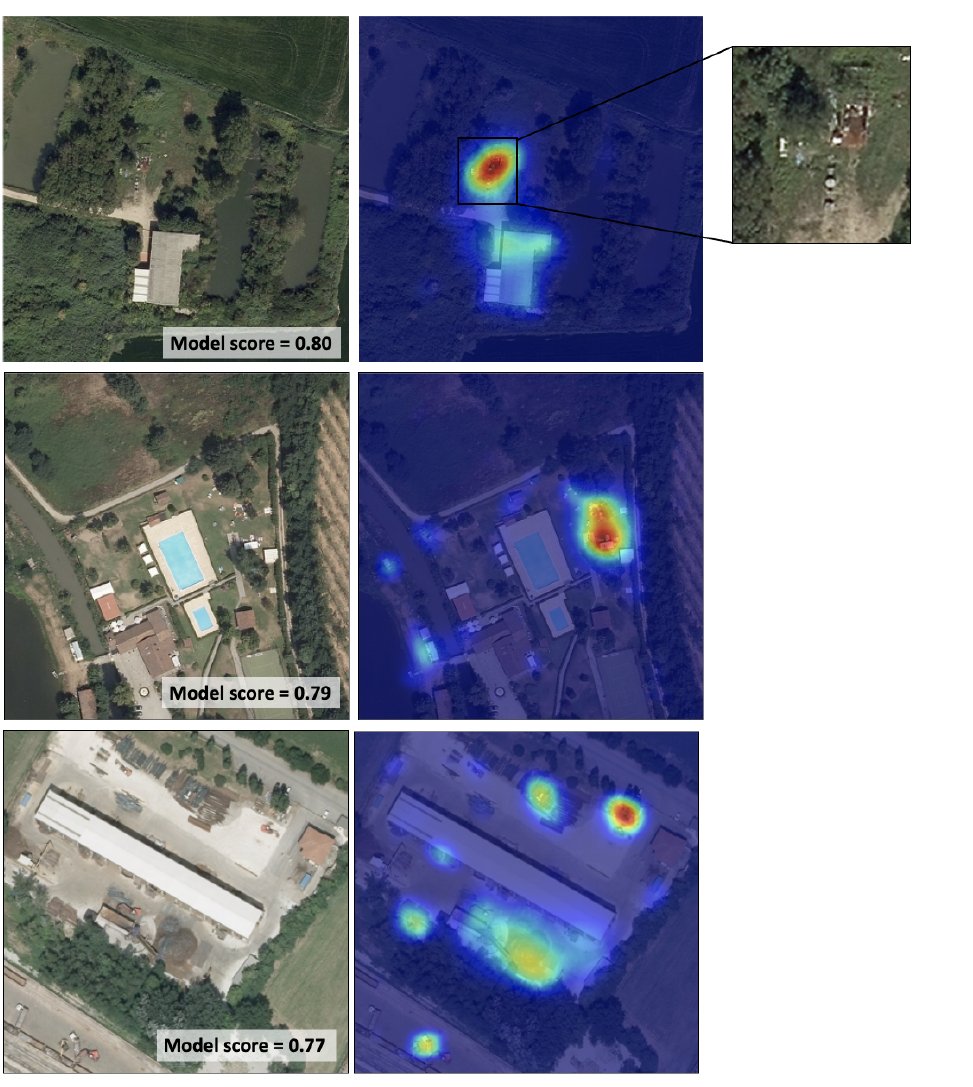
Figure 10. Examples of false